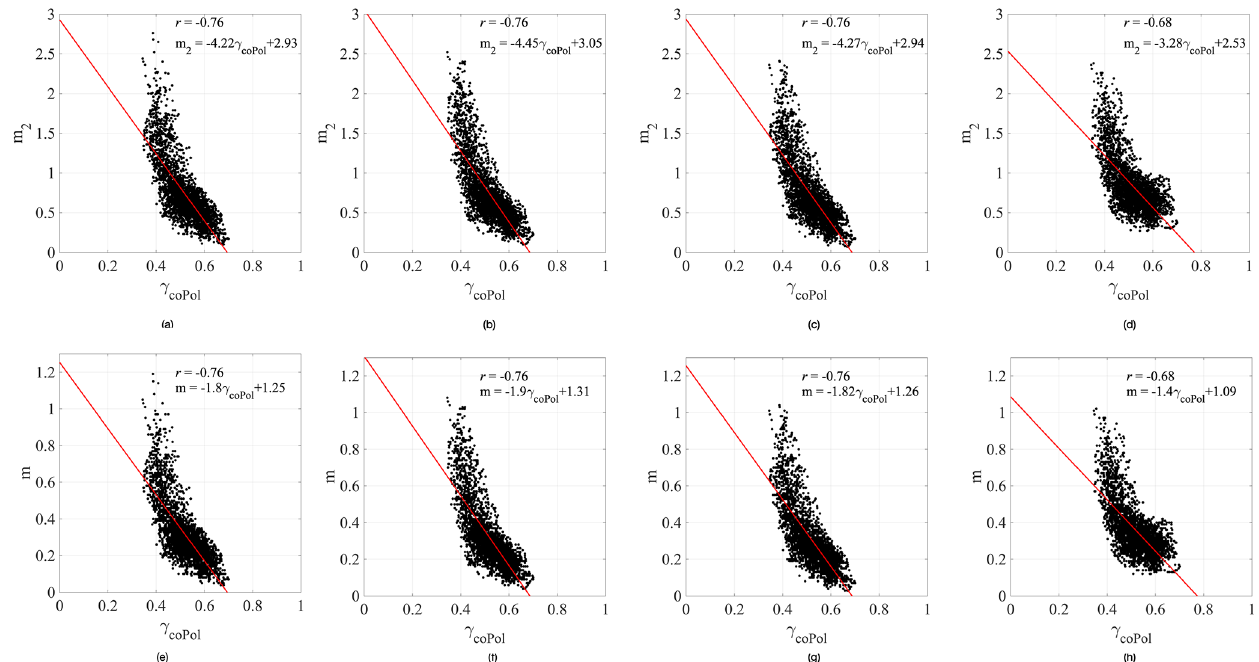
Figure 12. The relation between the bottom-layer layer-to-volume ratio m 2 (respectively m ) and the co-polarization (coPol) coherence γ coPol for the theoretical model (a–d) and the simplified model (e–h) . (a, d) HH polarization, (b, f) VV polarization, (c, g) Pauli 1 (HH + VV polarization), and (d, h) Pauli 2 (HH − VV polarization). Note the different y -axis scaling for m 2 and m